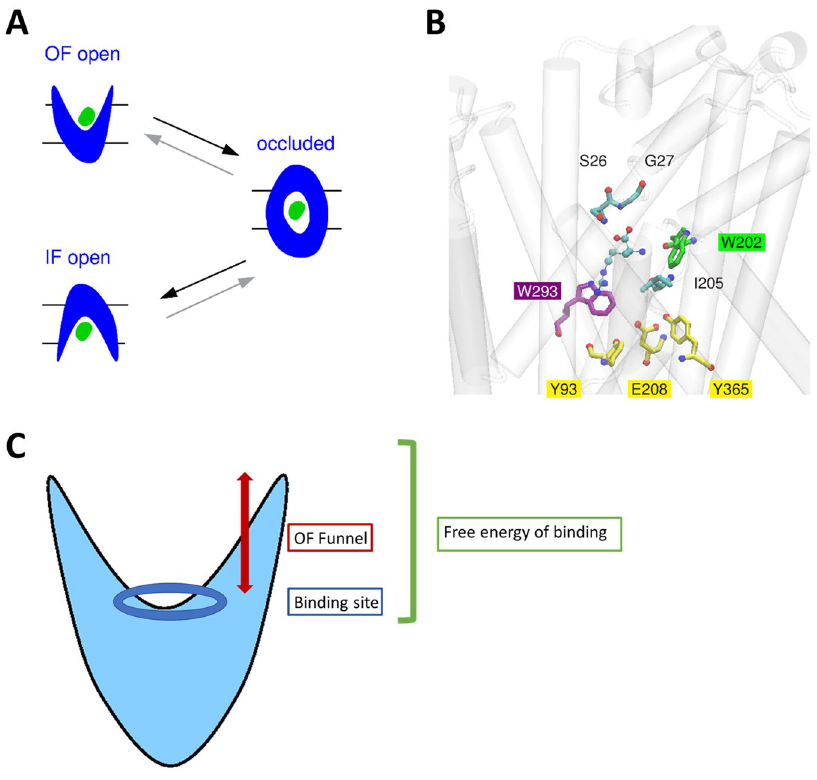
Figure 1. The AdiC transporter. ( A ) Schematic representation of the alternating access mechanism and of the main protein states occurring during transport. ( B ) Orientations of the gating residues in the OF open structure: the proximal and middle gate residues Trp202 and Trp293, respectively, and the distal gate residues Tyr93, Glu208, and Tyr365. The carbon atoms of the proximal, middle, and distal gate residues are respectively colored in green, purple, and yellow. The protein is shown as a transparent cartoon. The arginine ligand as well as Ser26 and Gly27 in the binding site are depicted as colored-atom sticks. ( C ) Schematic representation of the AdiC antiporter in the OF open conformation and possible selectivity filters for ligands: selection might occur during migration along the OF funnel to the binding site (red arrow) and/or in the binding site (blue ellipsoid), and/or it might result from the free energy balance of each ligand between the aqueous phase and the protein binding pocket (green